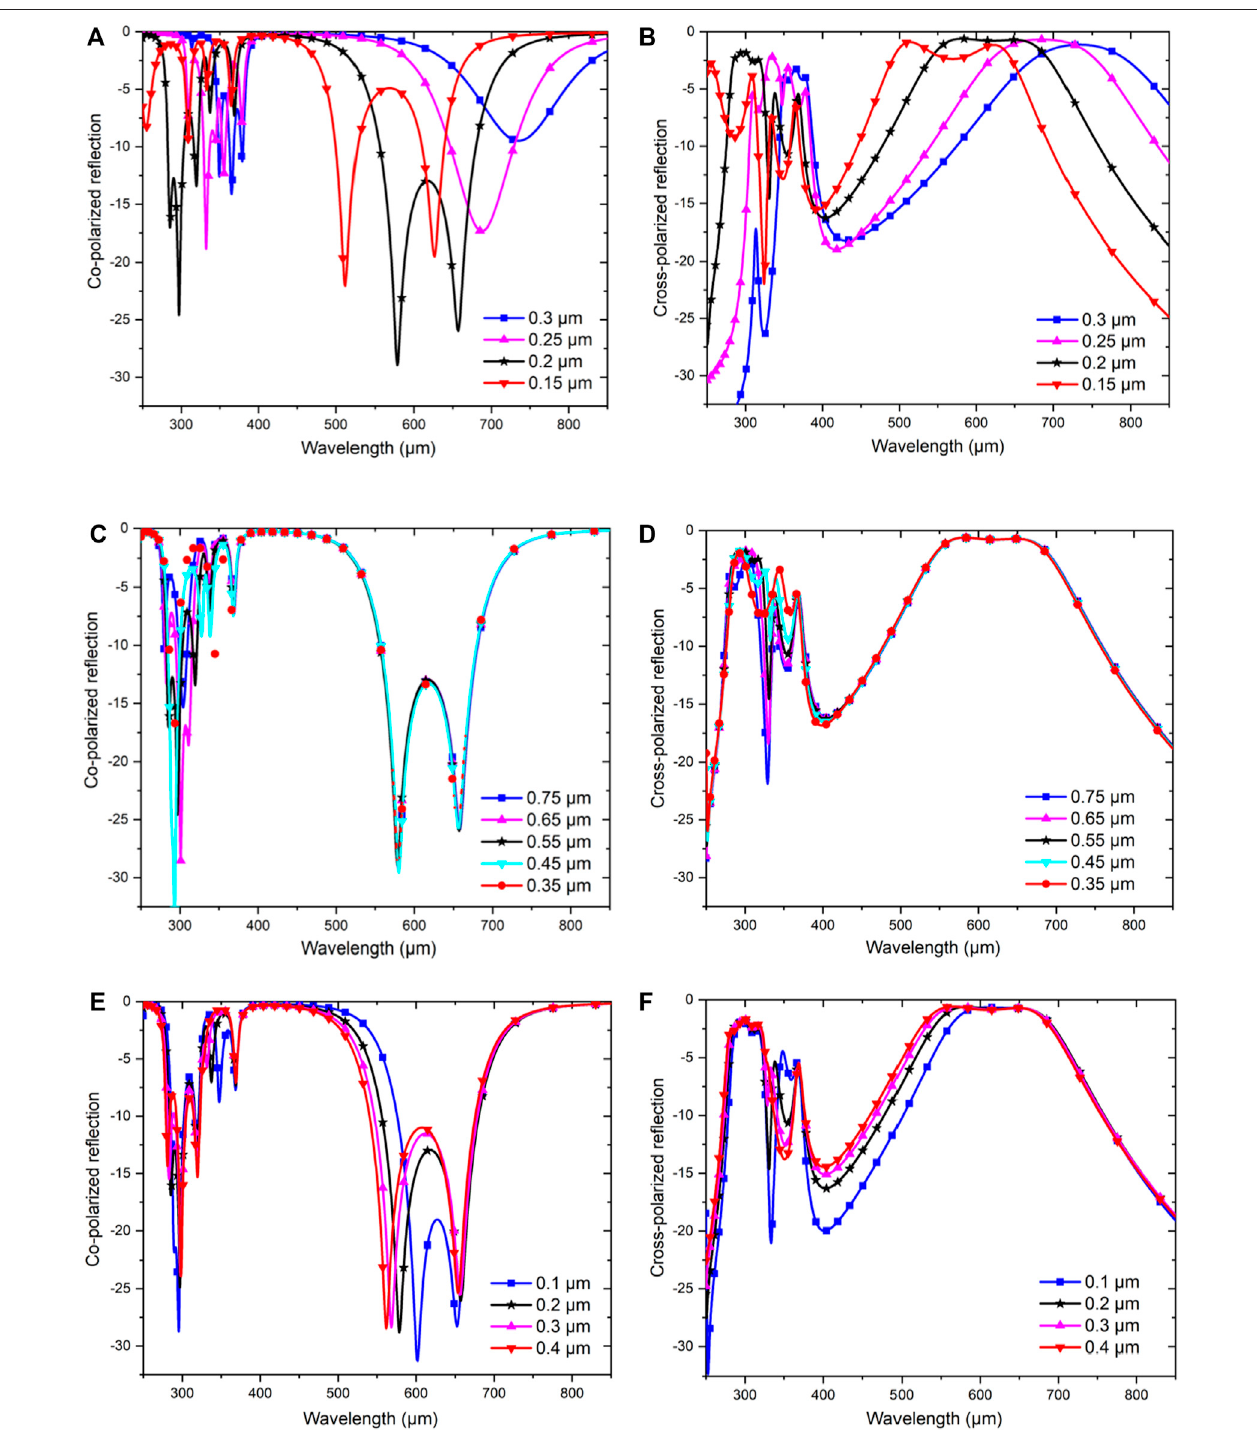
FIGURE 7 | Co- and cross-polarized re fl ectance responses based on varying (A,B) substrate thickness, (C,D) split length, and (E,F) split gap at the corner of the square-shaped resonator.